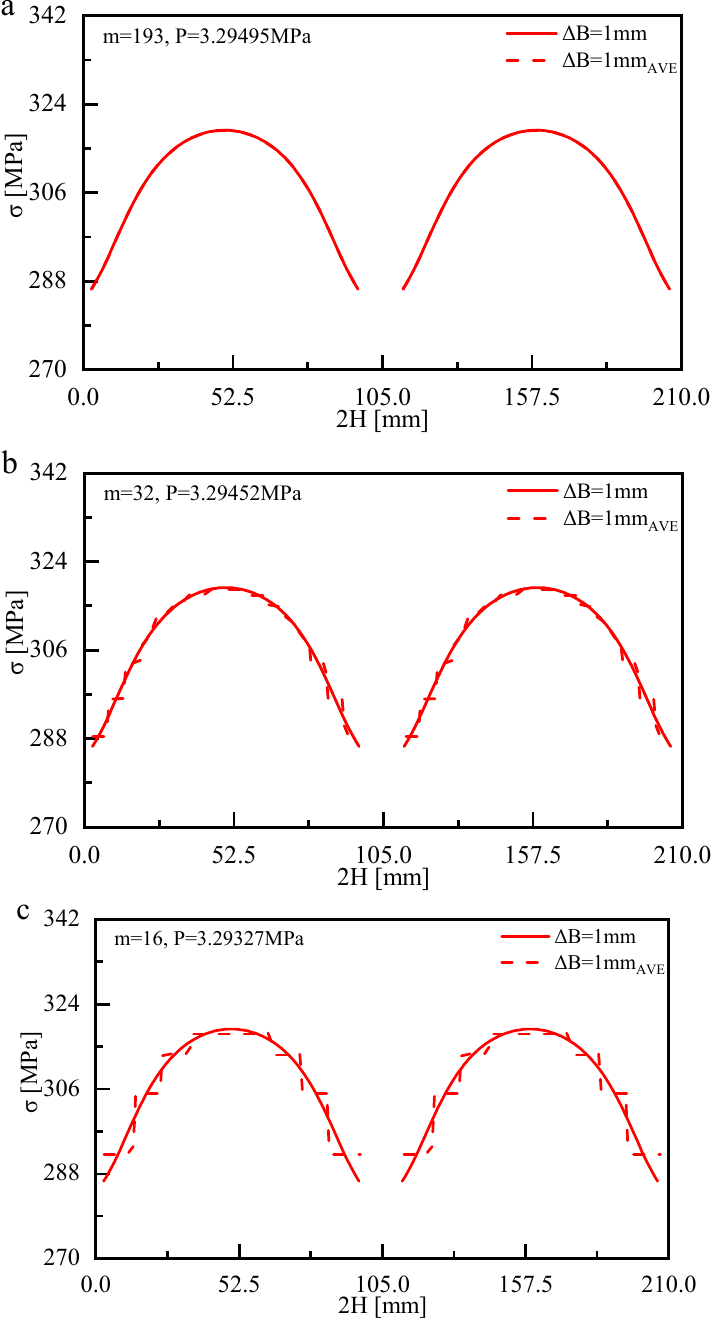
Figure 15. Typical example of division segments (m) used for the convergence analysis. (a)m=193; (b)m=32; (c)m=16.